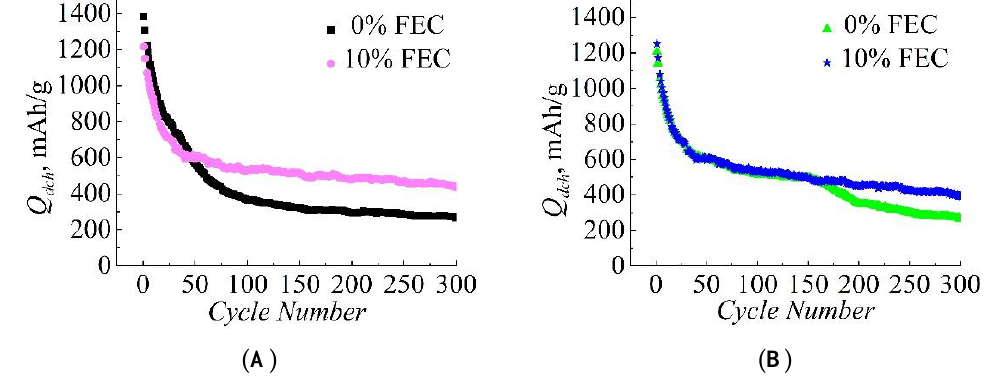
Figure 2. Dependence of the discharge capacity on the cycle number for samples with and without FEC in pairs ( A , B ).